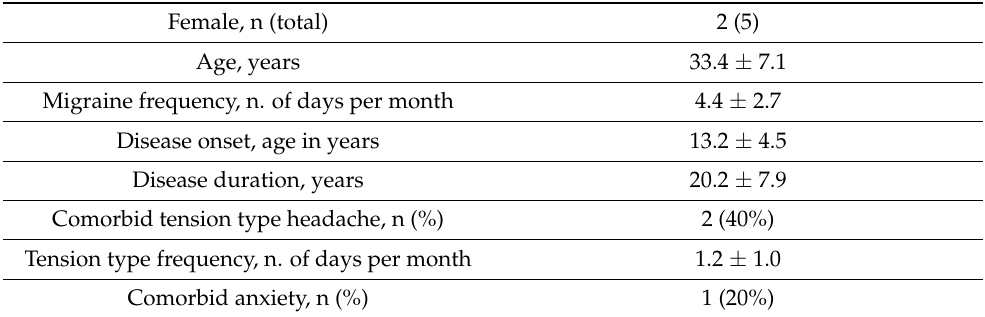
Table 2. Demographics of the cohort enrolled. Clinical and demographic characteristics are expressed as means ± SD.